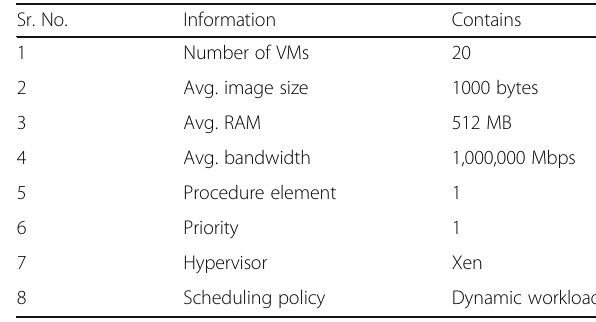
Table 14 Customer configuration